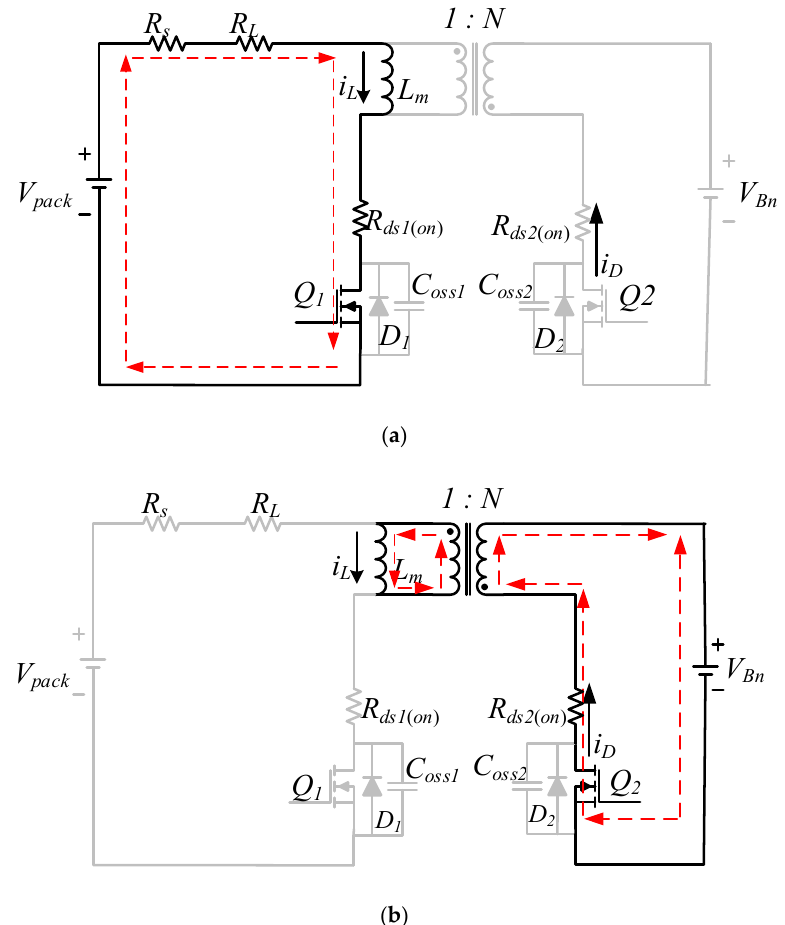
Figure 5. Equivalent circuit diagram of bidirectional flyback converter in ( a ) Interval I ( b ) Interval II.